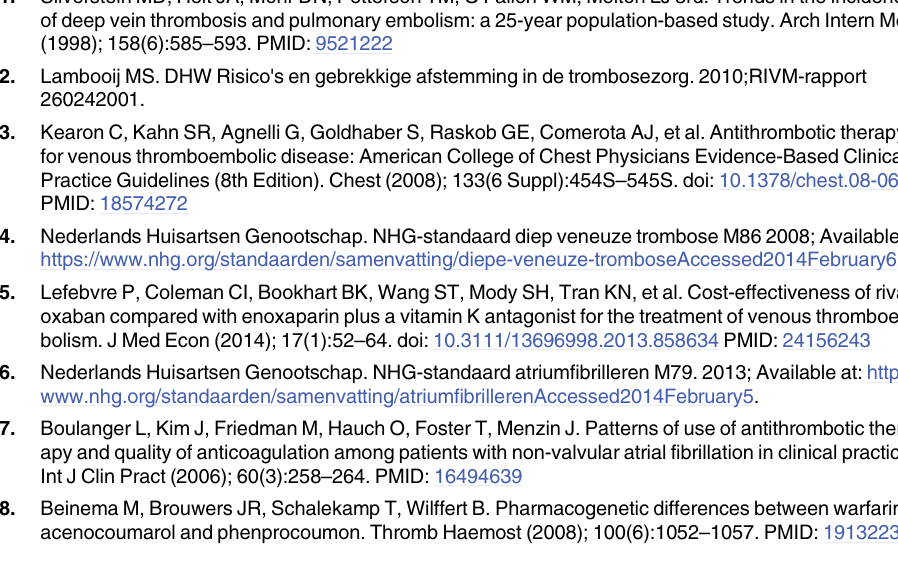
S3 Table. Cost parameters applied in the model ( € , 2013). Costs are determined for every health state and were assumed to follow gamma-distributions in the PSA. Same events costs are used for the scenario analysis. Anticoagulant costs and other costs are corrected to reflect the base case analysis (180 days) and specific scenario analysis (143 days). VTE: venous throm- boembolism; DVT: deep venous thrombosis; PE: pulmonary embolism; CRNM: clinically rele- vant non-major; 1 major bleeding utility is based on gastro-intestinal bleeding; 2 cost estimates that were only available as single point estimates were assumed to follow a gamma distribution with a 25% standard deviation of the